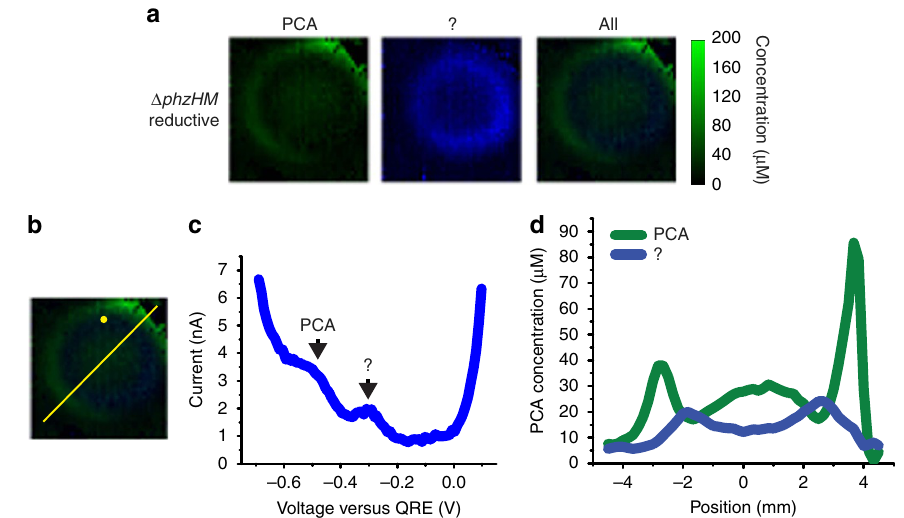
Figure 3 | Electrochemical imaging of a D phzHM biofilm. ( a ) Electrochemical imaging, based on reductive SWV, of a D phzHM biofilm after 2 days of development. Pixel intensity is proportional to PCA concentration. An unidentified compound provides the reductive peak at (cid:3) 300mV ( c ). Because the unidentified compound cannot be calibrated to concentration values, it is scaled relative to PCA based on SWVpeak current. PCA is shown in green and the unidentified compound in blue. Maximum error due to electrode variability is 28 m M for PCA. Images are 8mm (cid:2) 8mm. ( b ) Locations of example square- wave voltammogram and cross-section in c , d , respectively. ( c ) Example square-wave voltammogram from a single electrode. ( d ) Example cross-section from the electrochemical image in a . Because the unidentified redox-active species cannot be calibrated to concentration values, it is scaled relative to PCA based on SWV peak